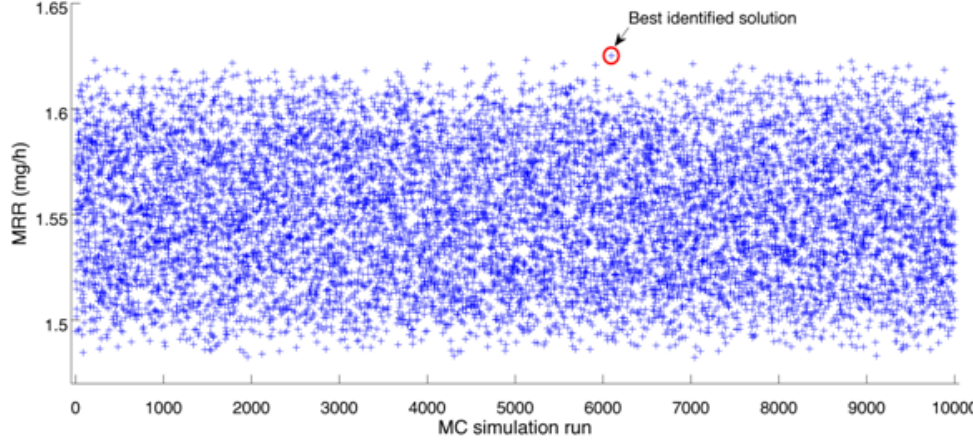
Fig. 3. Optimization solutions obtained using the multi-stage MC method for the case study